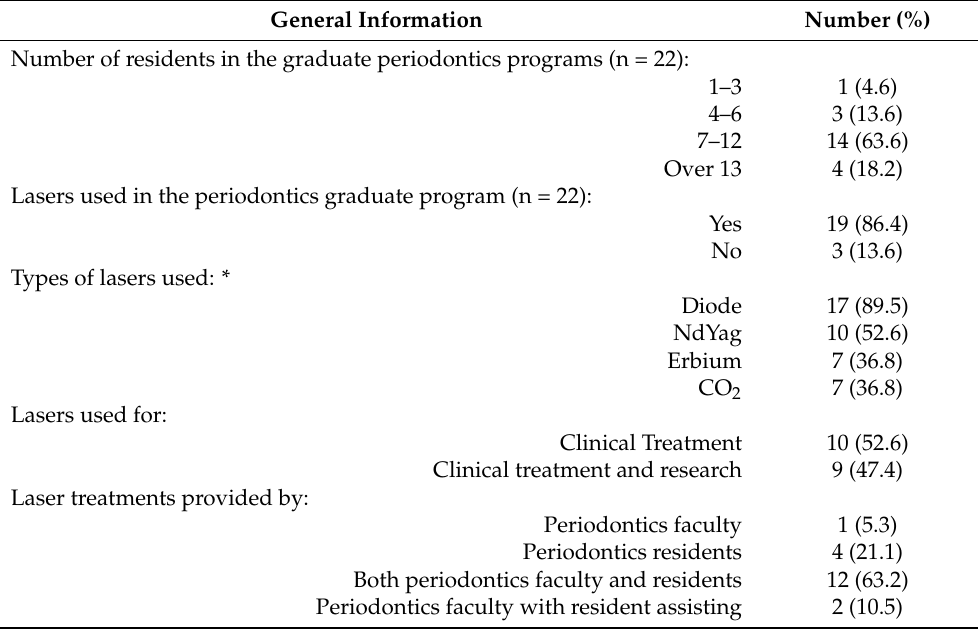
Table 1. General information related to use of lasers by periodontal professionals in the U.S. and Canada.